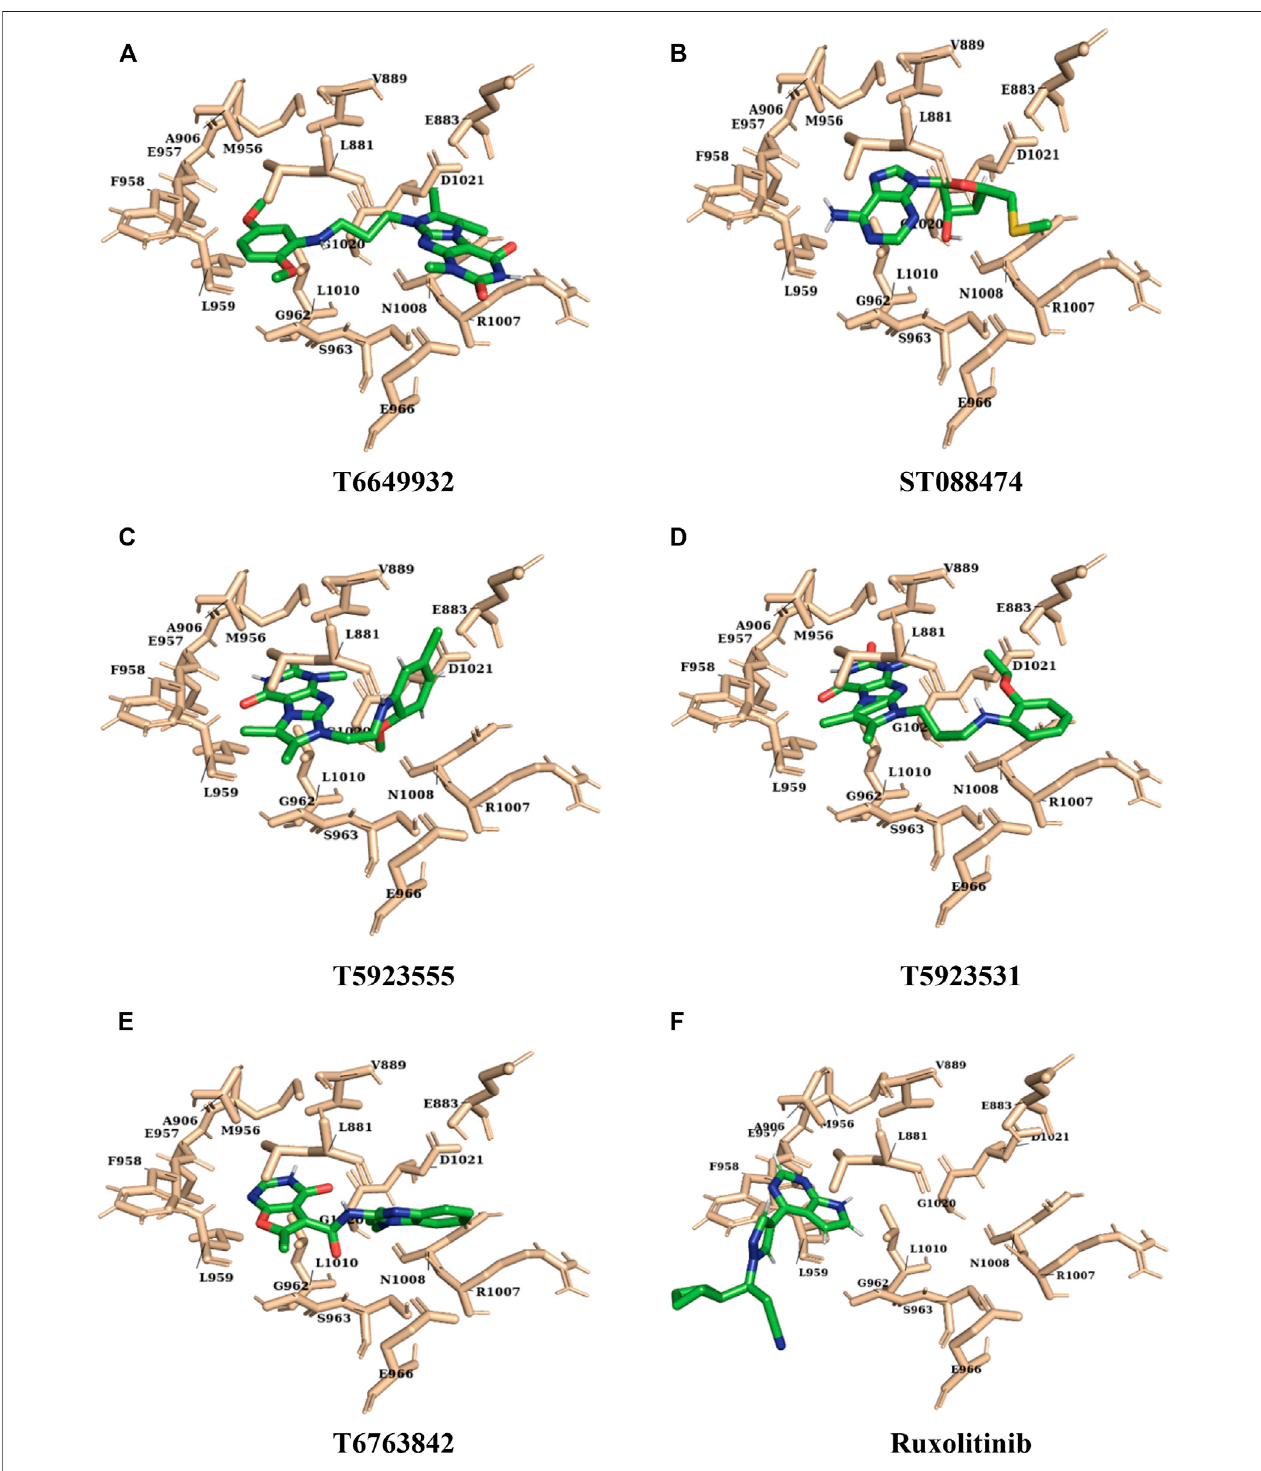
FIGURE 10 | The representation of fi nal conformation of the docked lead compounds and drug ( (A) T6649932, (B) ST088474, (C) T5923555, (D) T5923531, (E) T6763842, and (F) ruxolitinib) present inside the ATP-binding site of JAK after molecular dynamics simulation.